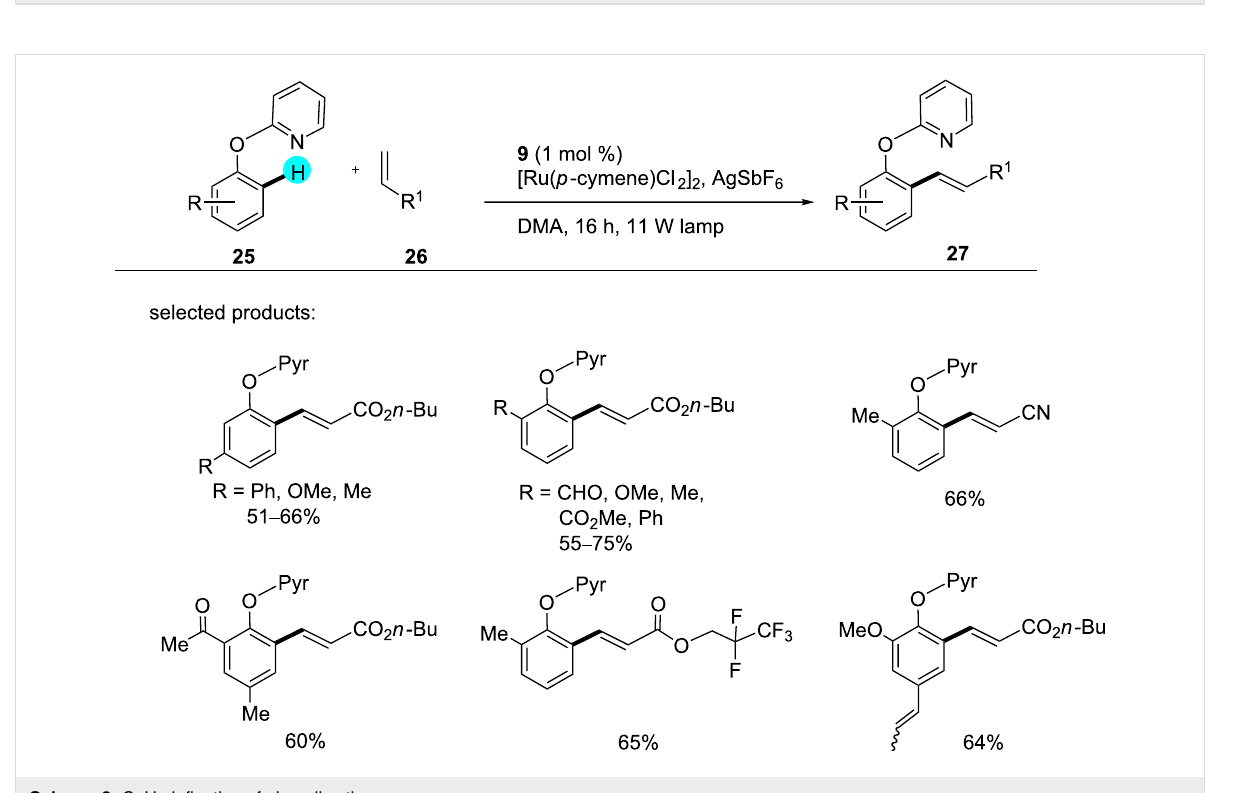
Scheme 2: C–H olefination of phenolic